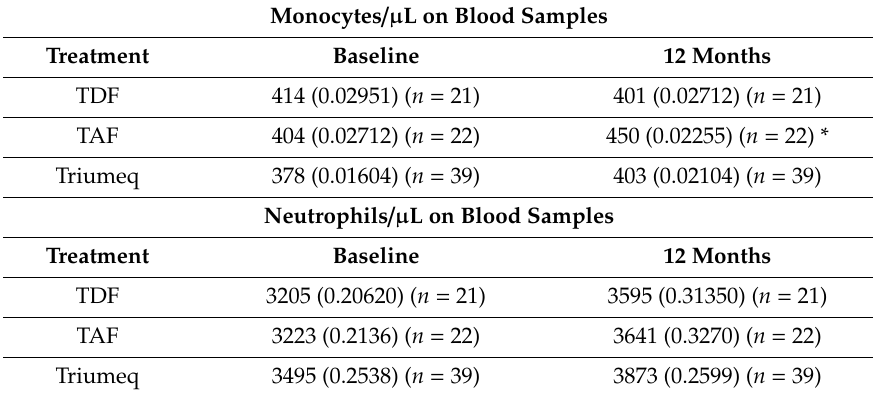
Table 3. Variation in monocytes and neutrophils between baseline and 12 months post-treatment. Mean cell / µ L (SEM) is represented. * p < 0.05 vs